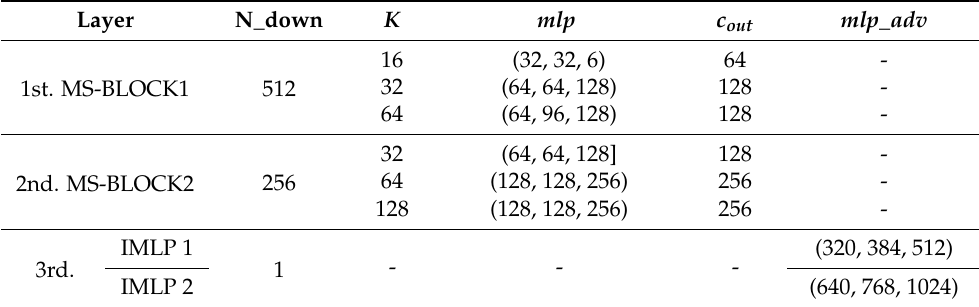
Table 1. Architecture configurations. N_down denotes the number of sampled points by FPS; K is the number of group neighbors in LFA-Cell; mlp indicates a list for MLP construction in layers; c out is the dimension of output (in Figures 4 and 5), which determines the size of bottleneck and scale; mlp _ adv denotes a list for scale; 𝑚𝑙𝑝_𝑎𝑑𝑣 denotes a list for IMLP.